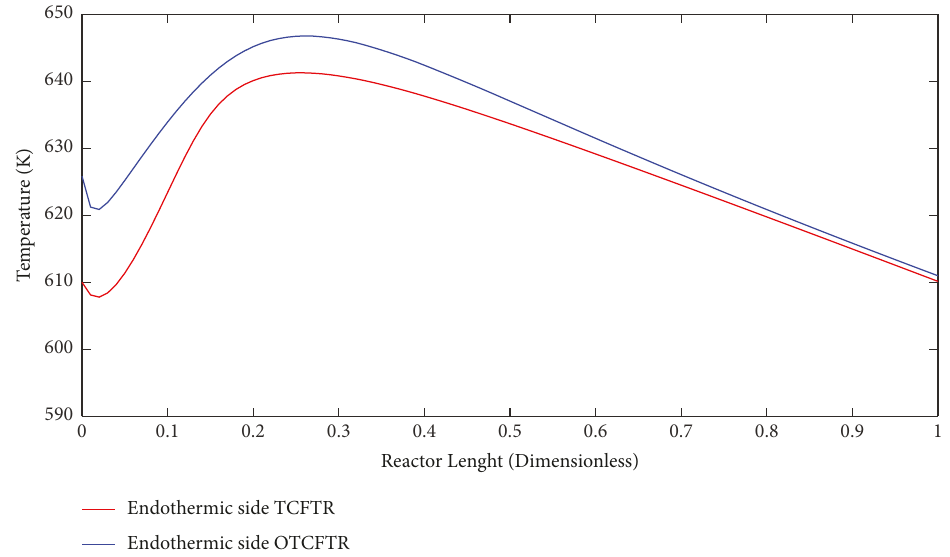
Figure 23: Comparison of the temperature profiles in TCFTR and OTCFTR modes in the endothermic part of the